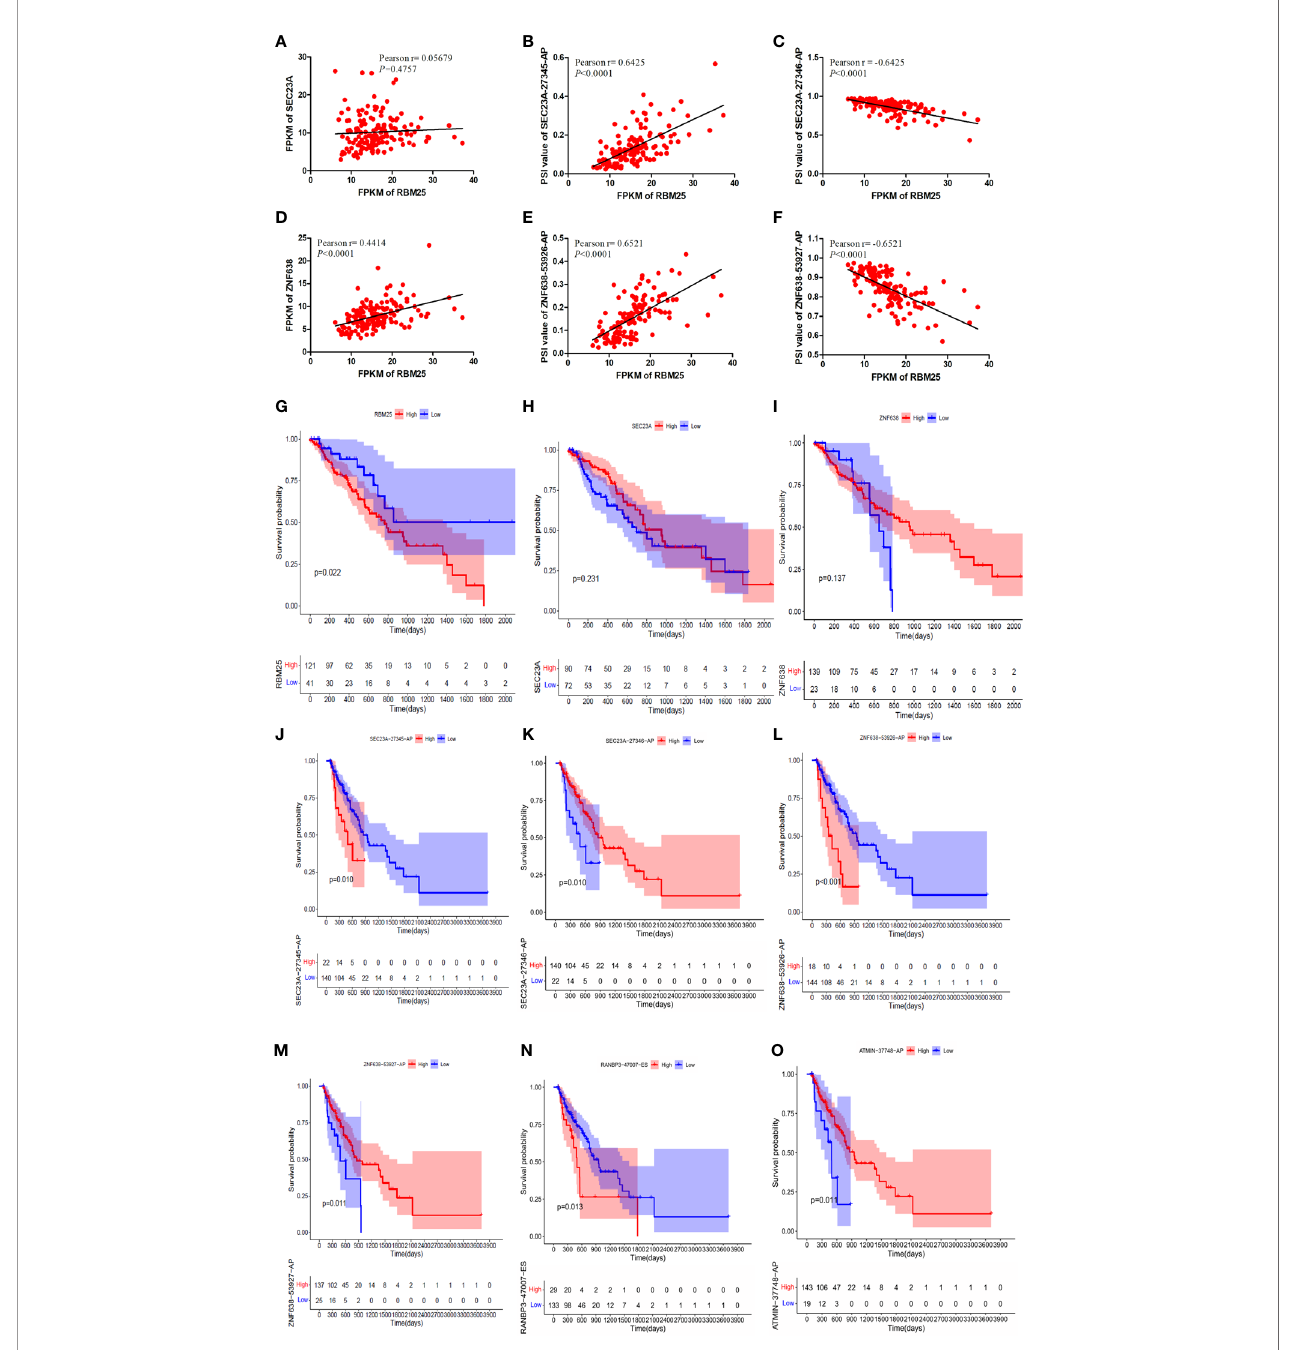
FIGURE 9 | The correlation analysis was performed using Pearson t -test and K-M curves. (A) There was no correlation between the expression of RBM25 and SEC23A ( P = 0.4757). (D) There was a weak correlation between RBM25 and ZNF638 ( P < 0.0001). RBM25 could positively regulate SEC23A-27345-AP (B) ( P < 0.0001) and ZNF638-53926-AP (E) ( P < 0.0001) and negatively regulate SEC23A-27346-AP (C) ( P < 0.0001) and ZNF638-53927-AP (F) ( P < 0.0001). RBM25 (G) ( P = 0.022), SEC23A-27345-AP (J) ( P = 0.010), and ZNF638-53926-AP (L) ( P < 0.0001) were all negatively related to the OS of EC patients. On the contrary, SEC23A-27346-AP (K) ( P = 0.010) and ZNF638-53927-AP (M) ( P = 0.011) were positively related to the OS consistent with the regulation of expression level. The parental genes SEC24A (H) ( P = 0.231) and ZNF638 (I) ( P = 0.137) were not the prognosis predictors of EC. RANBP3-47007-ES (N) was negatively related to the OS of EC patients. The patients with low PSI of RANBP3-47007-ES had better outcomes ( P = 0.013). ATMIN-37748-AP (O) and SEC23A-27346-AP (I) were positively related to the OS of EC patients. The patients with high PSI of ATMIN-37748-AP had better outcomes ( P = 0.011).